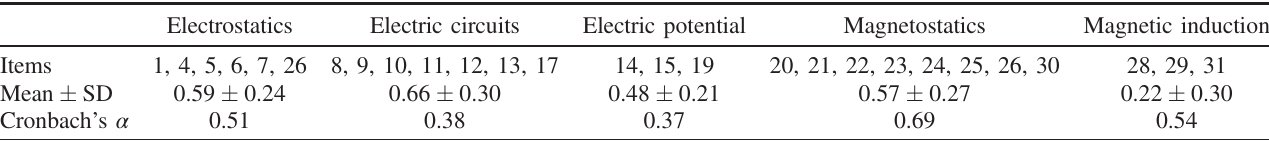
TABLE V. Subscale scores for each topic. The mean (cid:3) the standard deviation (SD) are shown. The mean calculates the average fraction of item in the subscale answered correctly by the